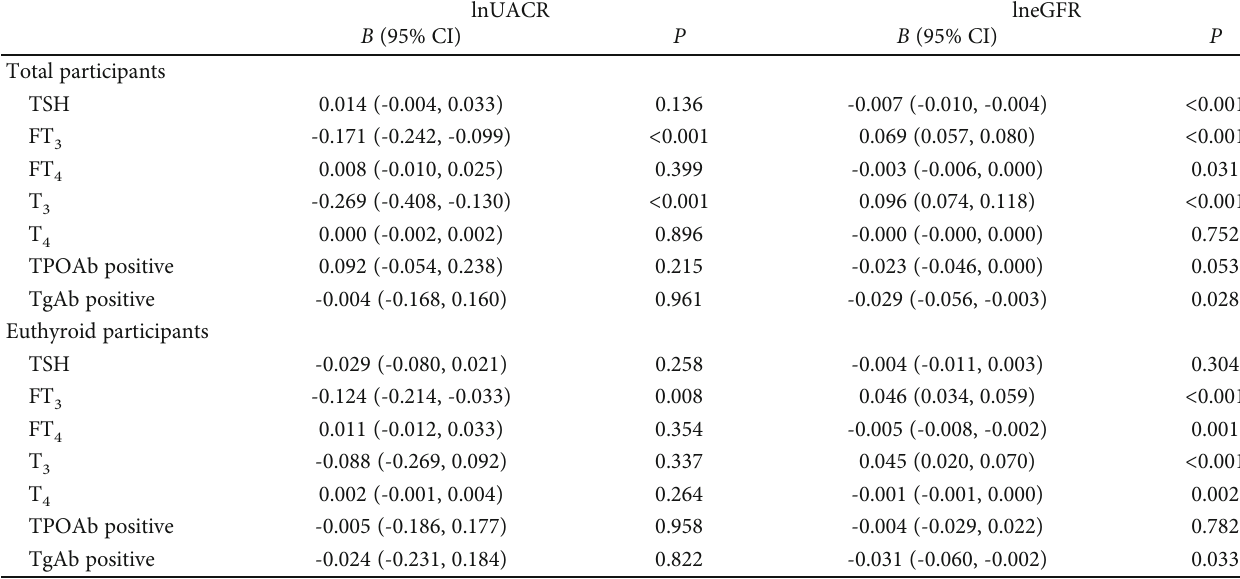
Table 2: Association of thyroid parameters with UACR and eGFR by linear